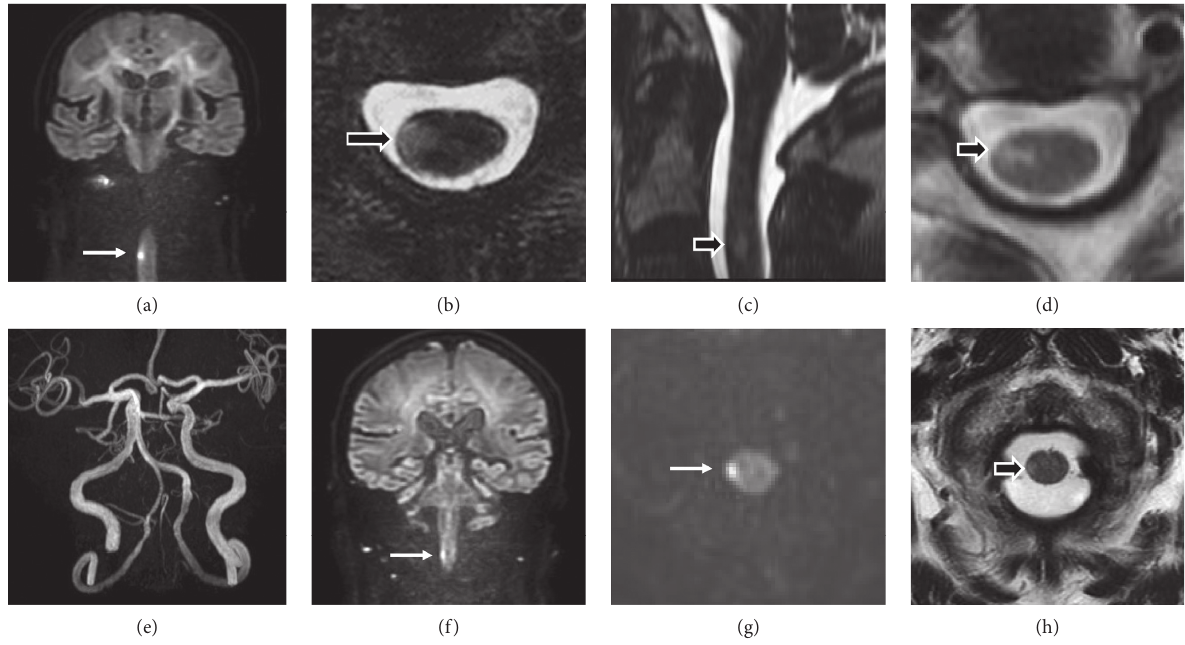
Figure 1: Magnetic resonance imaging (MRI) of spinal infarctions in two cases. The lesion for case 1 is presented in (a–e). (a) Thin-section coronal diffusion-weighted imaging (DWI), showing a high-intensity lesion of the cervical spine (arrow). (b and c) 3D fast imaging employing steady-state acquisition; MRI showing an upper cervical lesion. Axial (b) and sagittal (c); MRI showing a small, high-intensity lesion (arrows) at the level of the C2/3 intervertebral disc. (d) Axial, T2-weighted image of the cervical cord, examined 5 weeks after onset. (e) MR angiography of case 1, showing no apparent dissection of vertebral arteries. The MRI findings of case 2 are presented in (f–h). (f) Thin-section, coronal DWI and (g) axial DWI, demonstrating a high-intensity lesion (arrows) in the upper cervical cord. (h) T2-weighted axial image, showing a high-intensity lesion (arrow) in the right lateral funiculus at the level of the C1 vertebra.